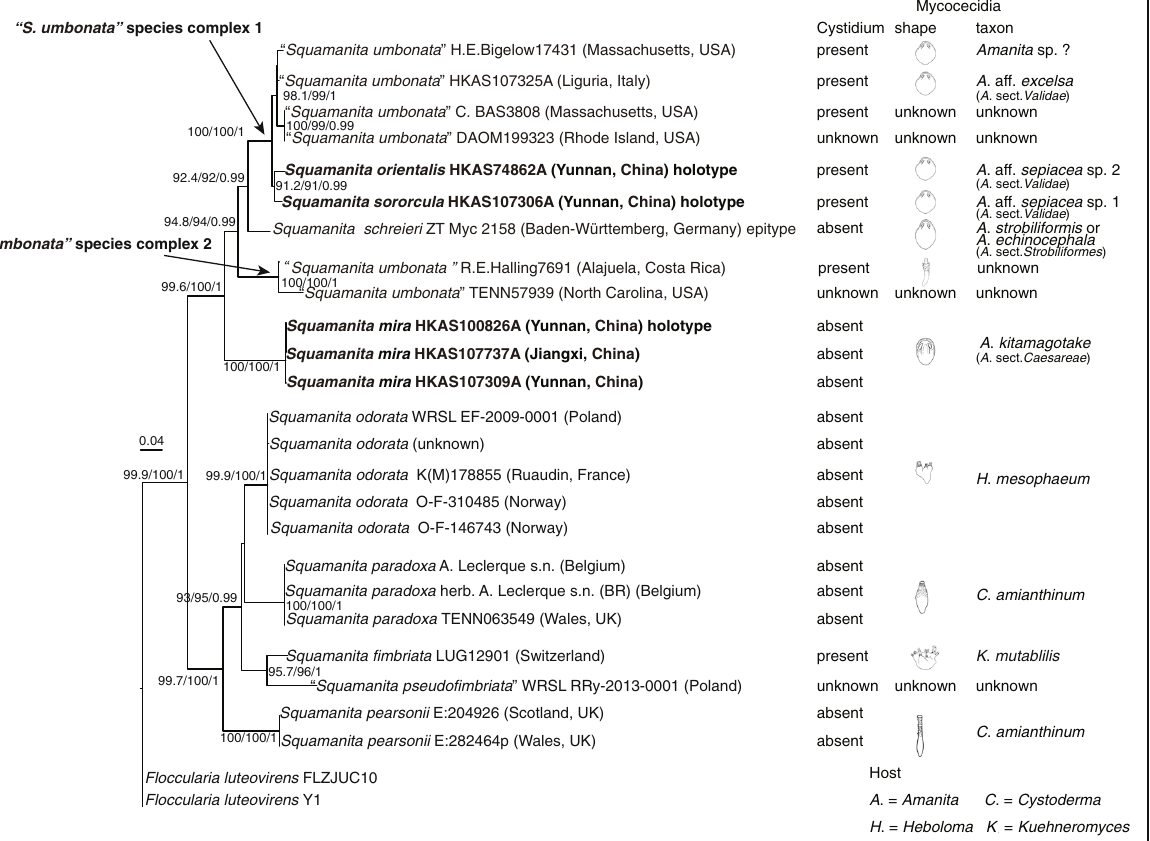
Fig. 3 Maximum-Likelihood (ML) phylogenetic tree of Squamanita inferred from the 18S-ITS-nrLSU-RPB2-TEF1 - α dataset, with SH-aLRT (left), ultrafast bootstrap (UFB) (middle), and PPs values (right) near by the corresponding node. Only one of SH-aLRT > 80 or UFB > 95 for ML and PPs > 0.90 for BI are indicated along branches (SH-aLRT/UFB/PP). Cystidium present or absent, and the shape and taxon of mycocecidia of counterpart Squamanita species are shown. New species Squamanita mira , S. orientalis , S. sororcula are highlighted in